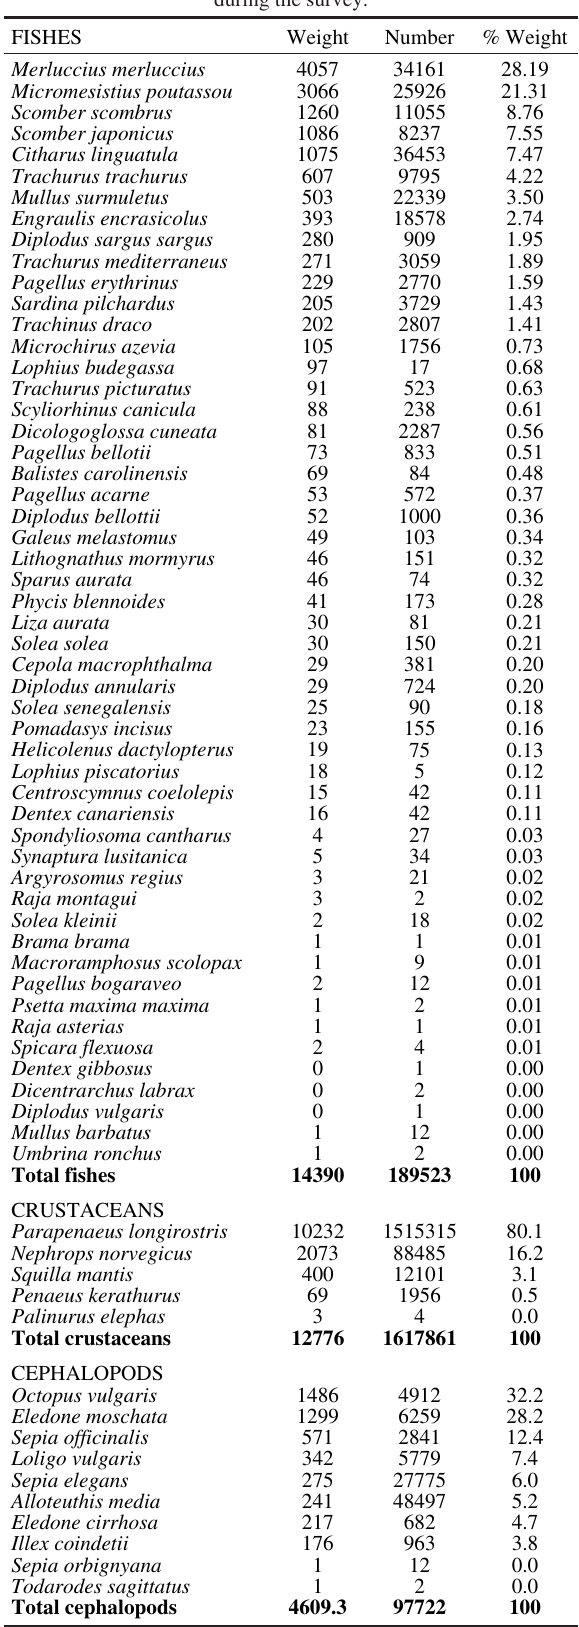
Table 3. – Total catches in weight (kg), number and weight percent- age of commercial species of fishes, crustaceans and cephalopods during the